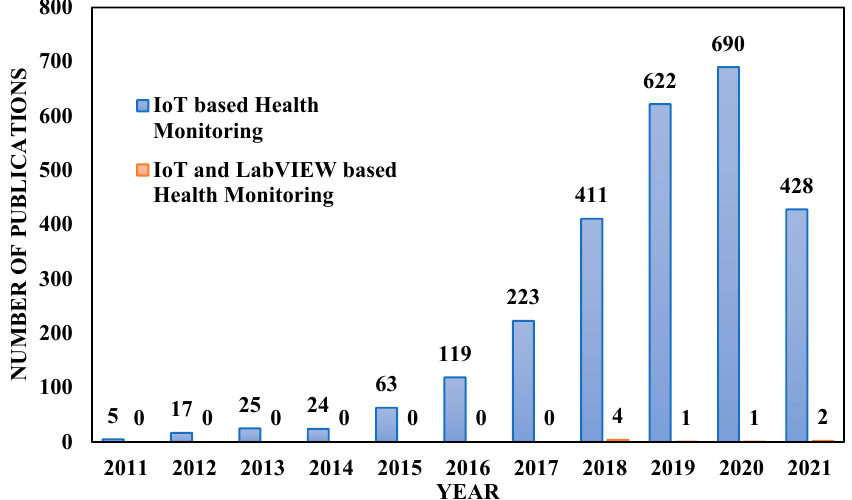
Figure 1. Publications statistics from Scopus database.